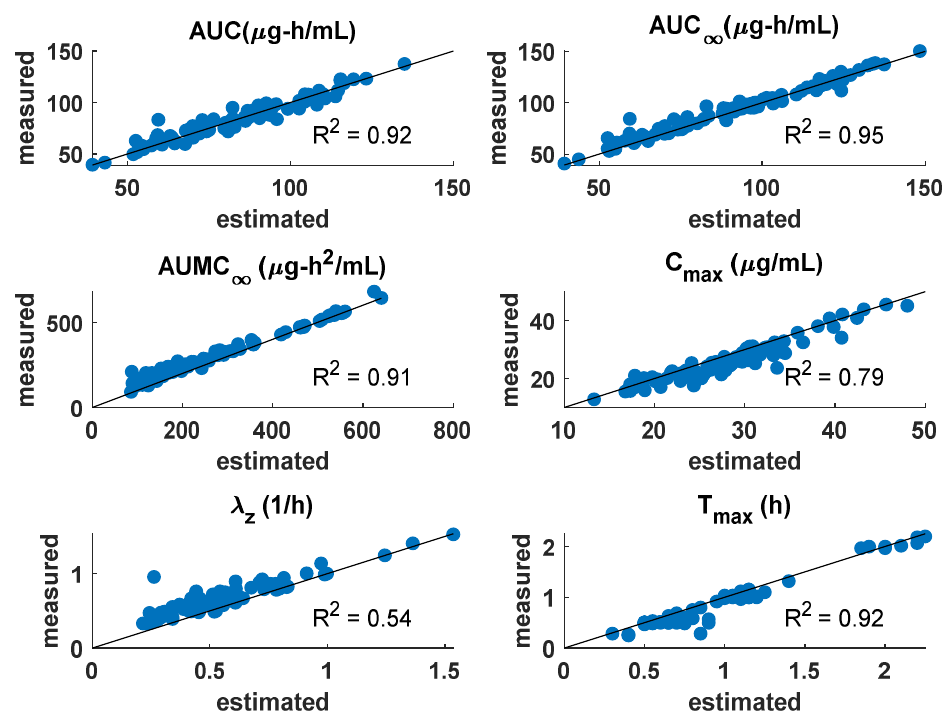
Figure 8. Goodness-of-fit plots for the PK model for the following clinical PK parameters: AUC, AUC ∞ , AUMC ∞ , C max , λ z , T max . Table 2. Pharmacokinetic model parameter values for HUSTLE participants.